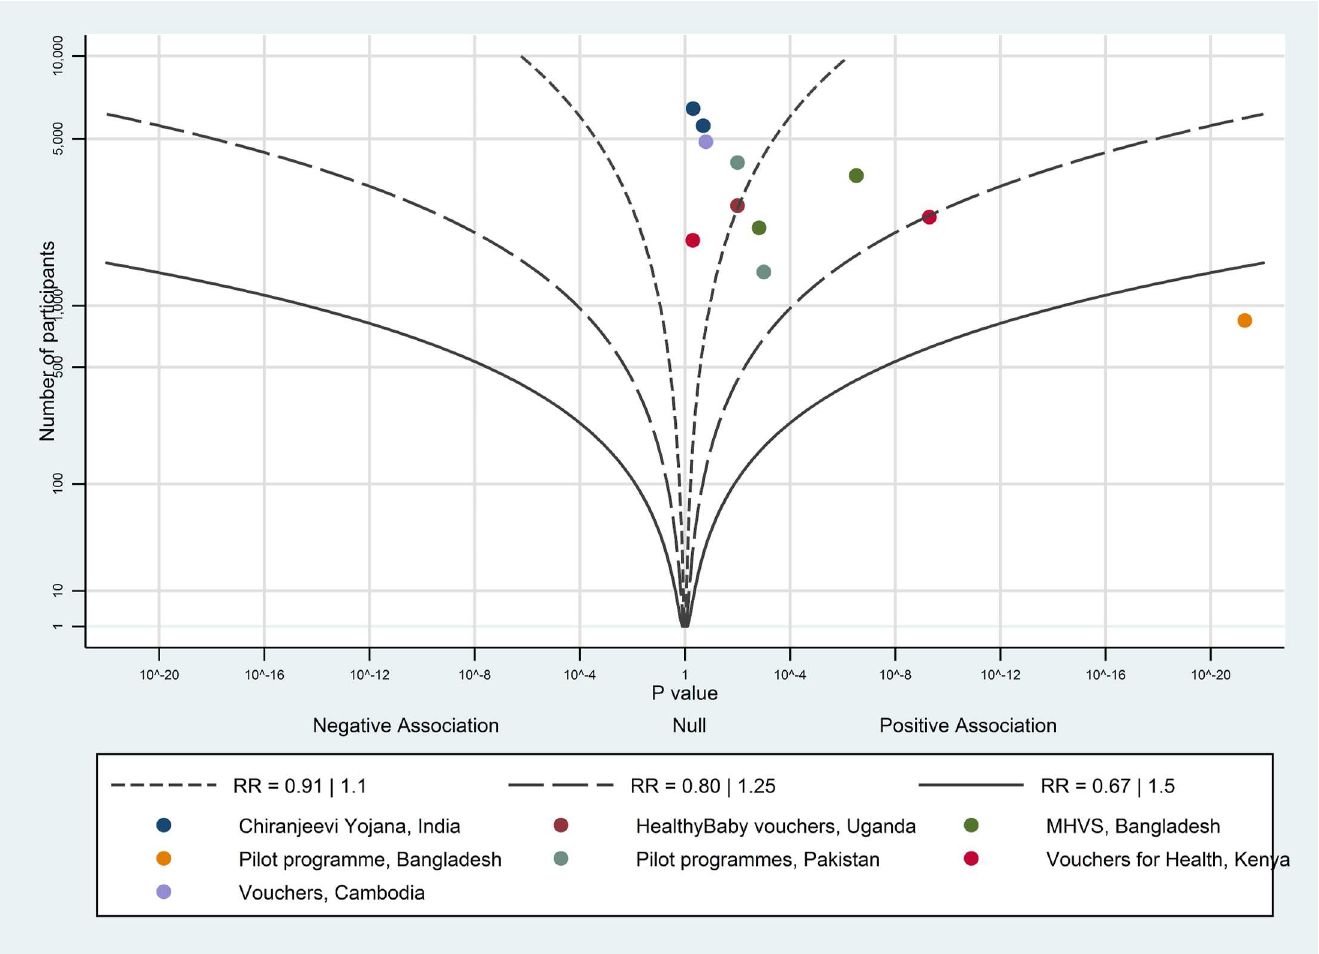
Fig 9. Albatross plot for effect of vouchers for maternity care serviceson uptake of antenatal care. MHVS—Maternal Health Voucher